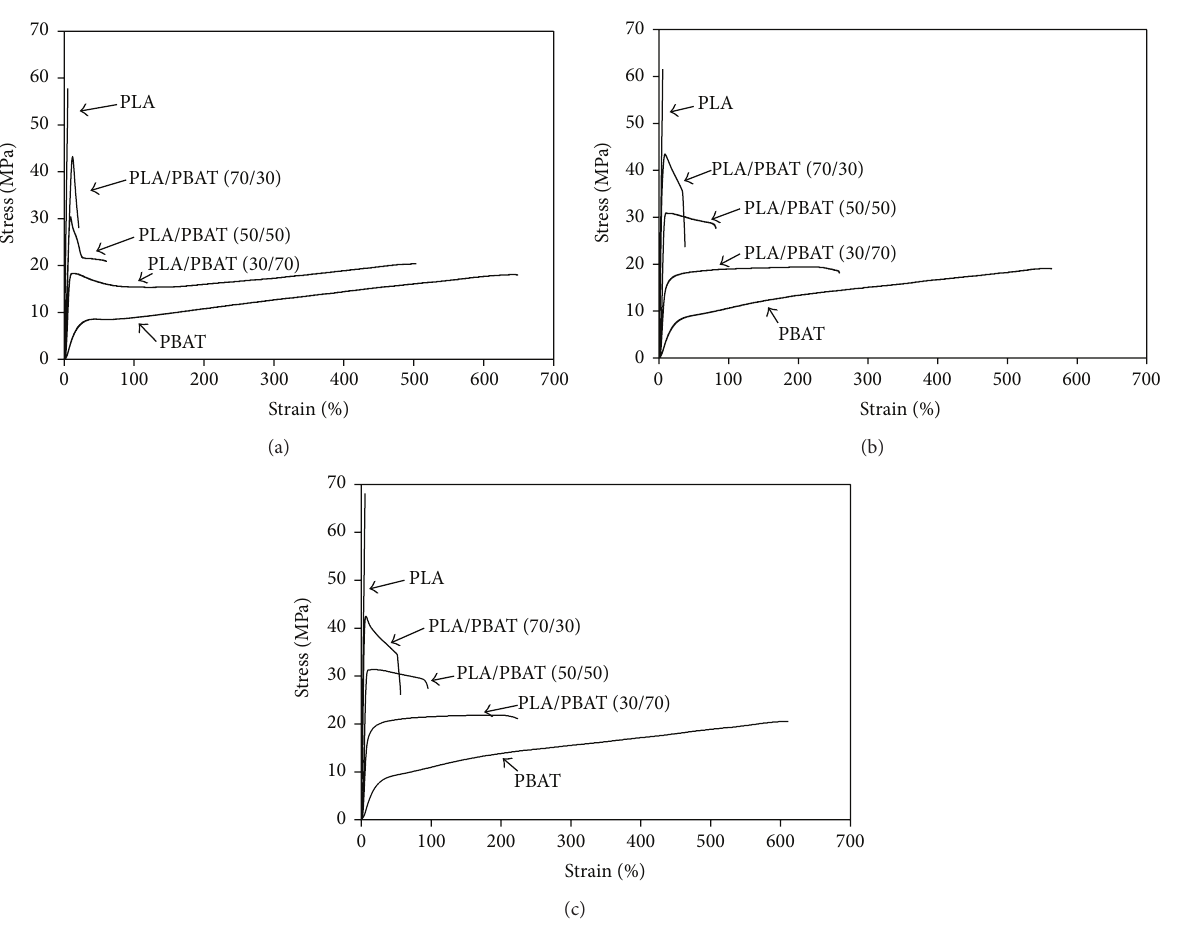
Figure 6: The tensile stress-strain curves of PLA/PBAT blends recorded at room temperature (27 ∘ C). (a) Untreated, (b) Annealed at 100 ∘ C for 8hrs, (c) annealed at 100 ∘ C for 24